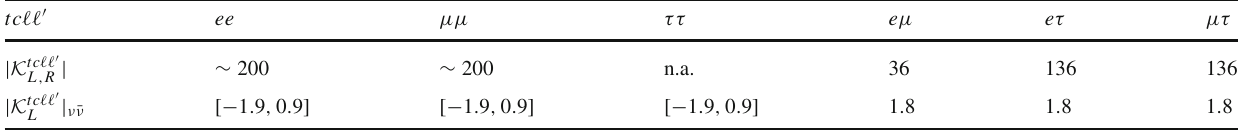
Table 7 Upper limits on charged dilepton couplings K tu (cid:4)(cid:4) (cid:2) lider studies [25–27] of top plus charged dilepton processes (top row), see text, and on charged dilepton couplings K tu (cid:4)(cid:4) (cid:2)